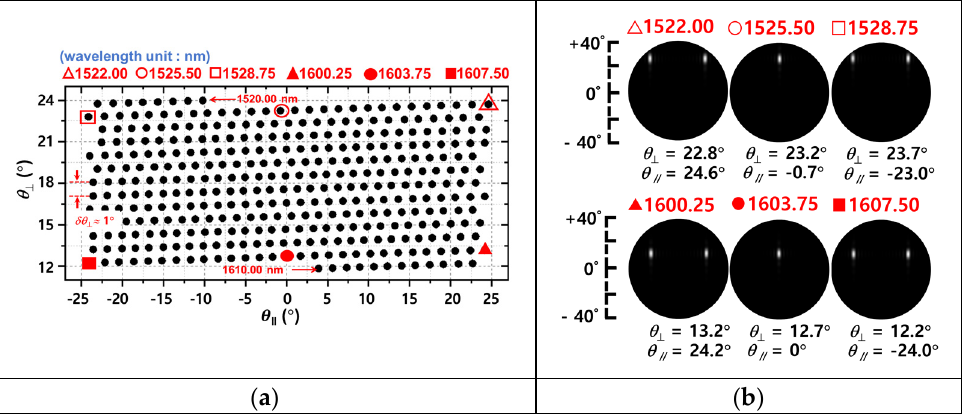
Figure 2. Simulation results of 2-D beam steering by wavelength tuning obtained from the grating radiator array with a pitch of 2 μ m and a path difference of 79.6 μ m in the phase-feeding lines. ( a ) Traces of the beam center during wavelength tuning from 1522.0 nm to 1607.5 nm and ( b ) far-field patterns corresponding to each of the three points on the first and last full traces in ( a ).